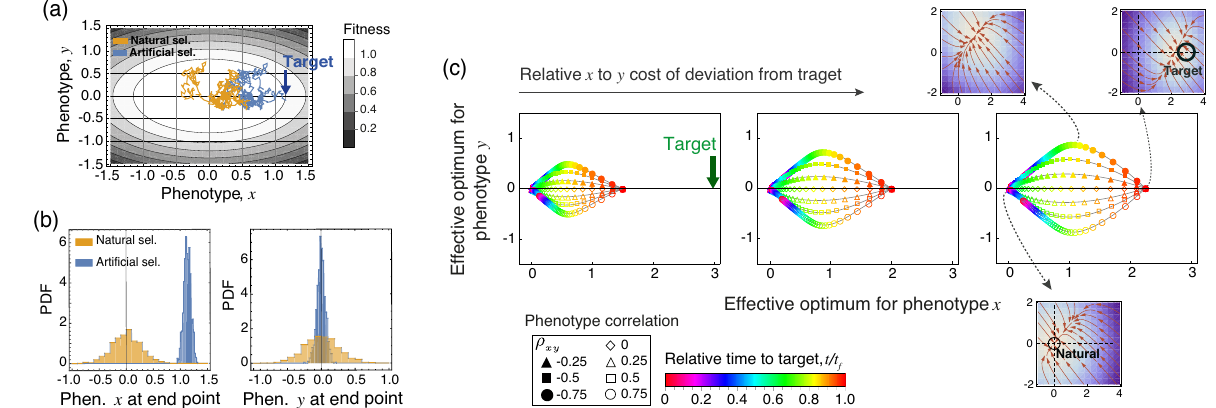
FIG. 3. Artificial selection on covarying phenotypes. (a) Trajectories for evolution under natural (orange) and artificial (blue) selection are shown for a 2D phenotype ð x; y Þ , in a quadratic landscape. Parameters are c 0 . 05 ; k 0 ; g 2 ; λ ¼ 0 . 01 . (b) The distribution of phenotypes at the end point of an artificial selection protocol (blue) is k g y ¼ xy ¼ x ¼ y ¼ compared to the phenotypic distribution under natural selection (orange). Evolutionary parameters are the same as in (a). (c) The dynamics of the effective fitness peak is shown over time (colors) for 2D covarying phenotypes with correlations ρ shape of the markers. From left to right, panels show increasing end point cost of deviation from the target along the x phenotype, 1 , 2, 3, with g 2 . Heat maps show the effective fitness landscapes associated with a specific fitness peak (indicated by the dotted g x ¼ y ¼ arrows) for anticorrelated phenotypes at three different time points. The direction and length of the red arrows in each heat map indicate the direction and the strength of selection pressure toward the effective optimum. Parameters are x (cid:3) ¼ 3 , y (cid:3) ¼ 0 ; c 0 . 02 ; λ ¼ 0 . 1 k k x ¼ y ¼ artificial selection protocol defines an effective two-dimen- sional quadratic fitness landscape that biases the evolu- tionary trajectories toward the target state [Fig. 3(a)]. As a result, the phenotype distributions at the end of the process become significantly distinct from the expectation under natural selection, and remain strongly restricted around their target values; see Fig. 3(b).